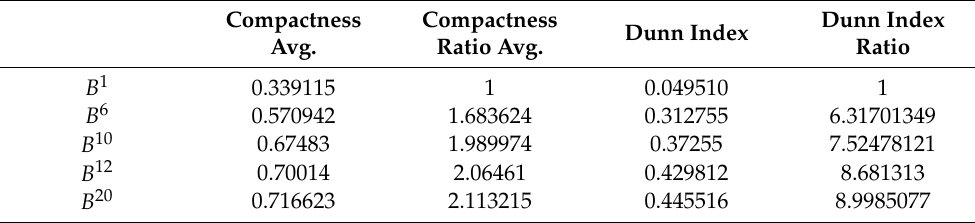
Table 4. Compactness, Donn index as we increase ultrametricity. Seeds dataset.